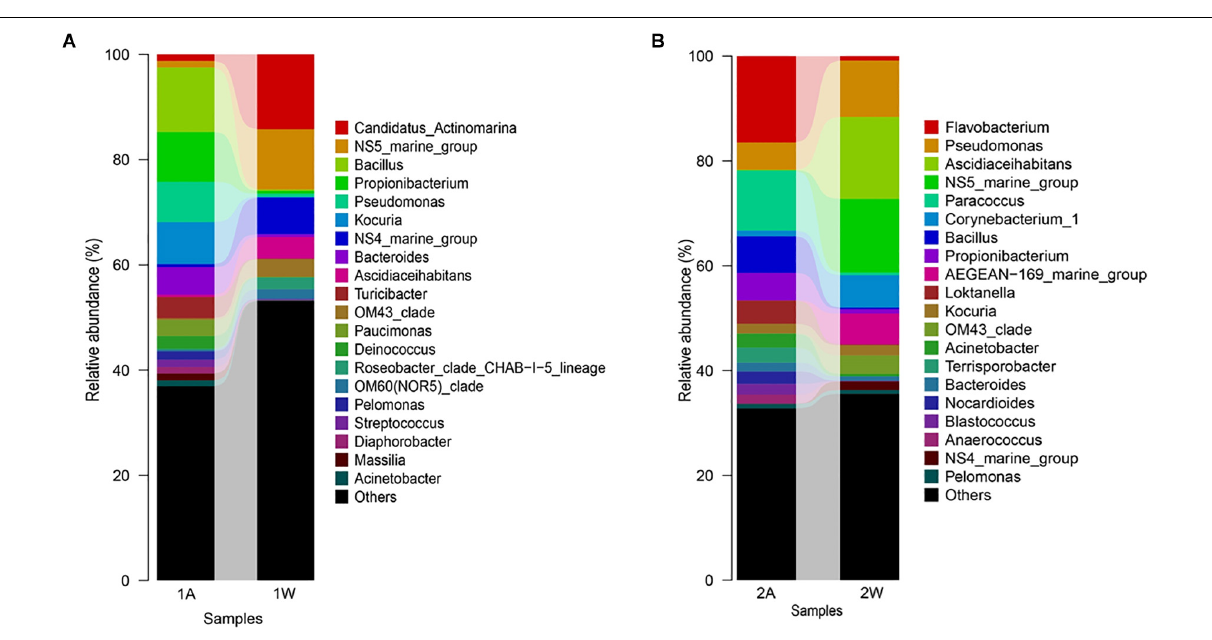
FIGURE 8 | Bar-plot of bacterial composition of S. horneri and surrounding seawater at genus levels. (A) Nearshore. (B) Offshore. 1A: total bacteria isolated from brown S. horneri , 1W: total bacteria isolated from nearshore seawater, 2A: total bacteria isolated from yellow S. horneri , 2W: total bacteria isolated from offshore